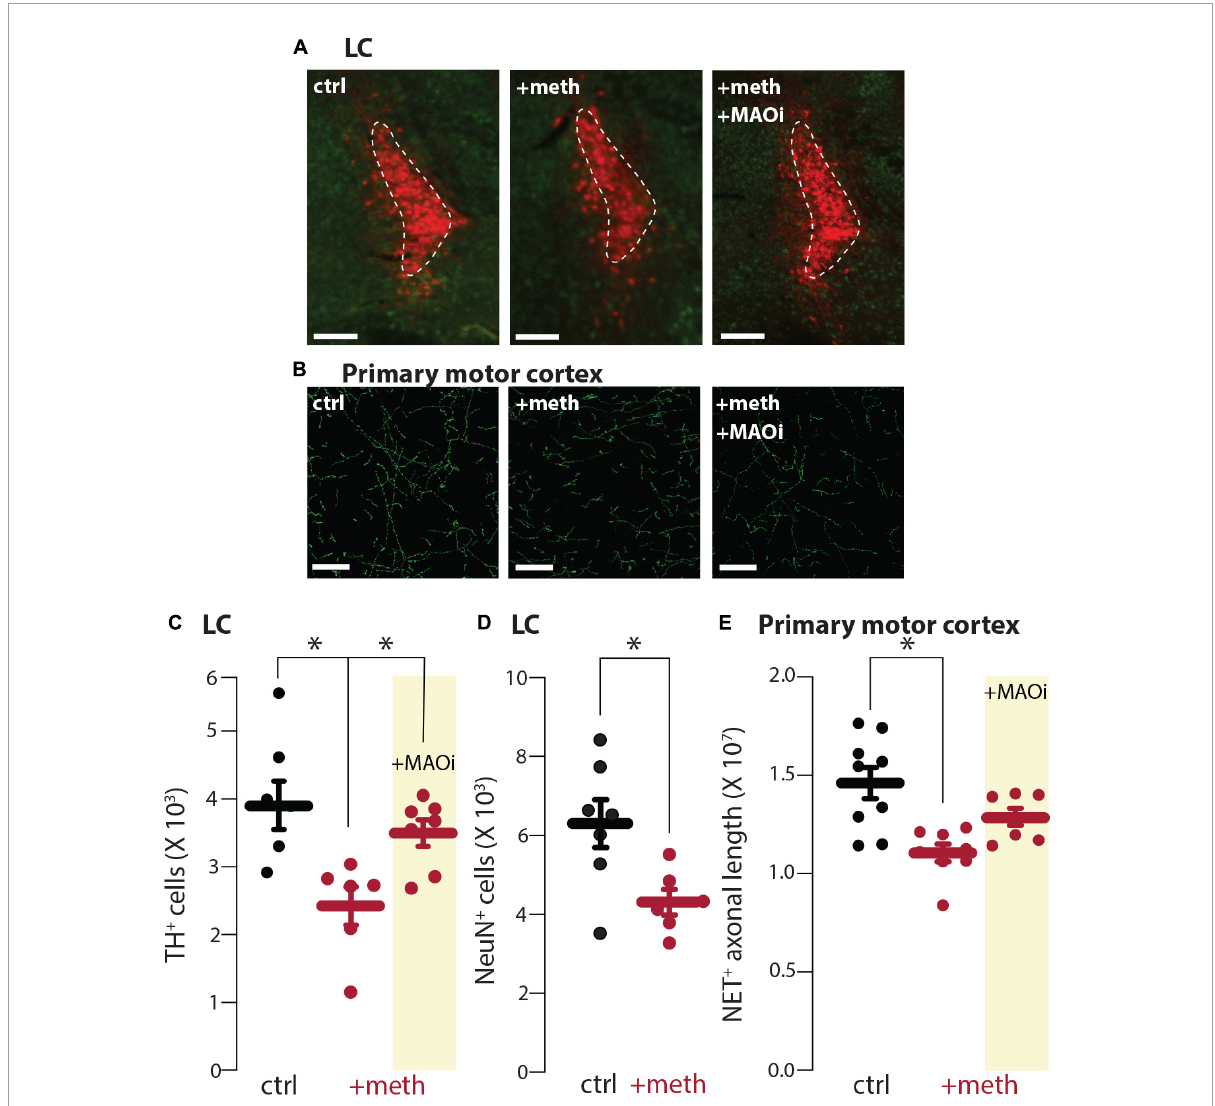
FIGURE3 Chronic meth administration induced locus coeruleus (LC) degeneration and monoamine oxidase (MAO) inhibition was neuroprotective. (A) Sample images depicting loss of tyrosine hydroxylase expressing (TH + ) neurons in LC of meth (+meth; 5 mg/kg)-compared to saline (ctrl; 10 ml/kg)-treated mice and neuroprotection by pretreatment of the MAO inhibitor rasagiline (+MAOi; 1 mg/kg); scale bars denote 200 µ m; TH stained in red with NeuN counterstained in green. (B) Sample images depicting NET + axons in the primary motor cortex of ctrl, +meth, and +MAOi mice; scale bars denote 20 µ m. (C) Quantified data indicate that chronic meth induced loss of TH + cells in the LC of meth-treated mice and this loss was prevented by pretreatment of rasagiline; ctrl n = 7, +meth n = 6, +MAOi n = 7 mice. Data analyzed using one-way ANOVA [ F ( 2 , 17 ) = 6.585, p = 0.0076] with Tukey post-hoc (ctrl vs. +meth, p = 0.0067; ctrl vs. +MAOi, p = 0.5891; +meth vs. +MAOi, p = 0.0484). (D) Quantified data indicate that chronic meth induced loss of NeuN + cells in the LC of meth-treated mice; ctrl n = 7, +meth n = 6. Data analyzed using an unpaired t -test [ t ( 11 ) = 2.746, p = 0.0190, two-tailed]. (E) Quantified data show loss of NET + axons in +meth mice; ctrl n = 9, +meth n = 8, +MAOi n = 7 mice. Data analyzed using one-way ANOVA [ F ( 2 , 21 ) = 8.670, p = 0.0018] with Tukey post-hoc (ctrl vs.